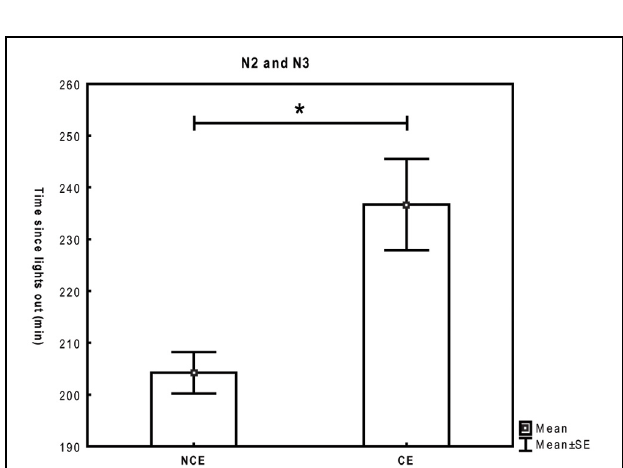
FIGURE 5 | Time since lights out (mean and standard error of mean) for questionings associated with conscious experiences (CE) and no conscious experiences (NCE) in stages 2 and 3 (seven subjects). Paired t -test. ∗ p < 0 . 05.